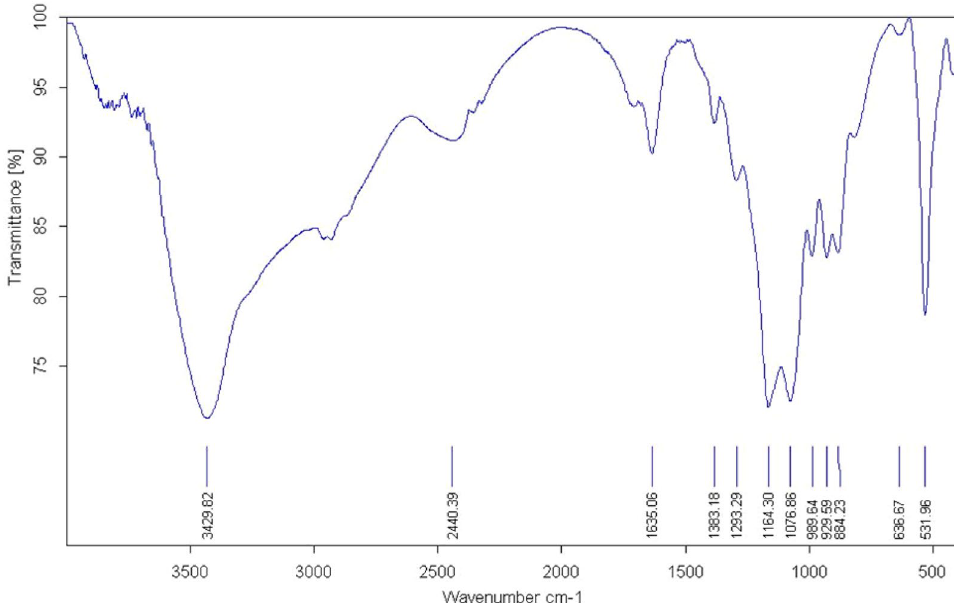
Figure 1. IR spectrum of synthesized graphene